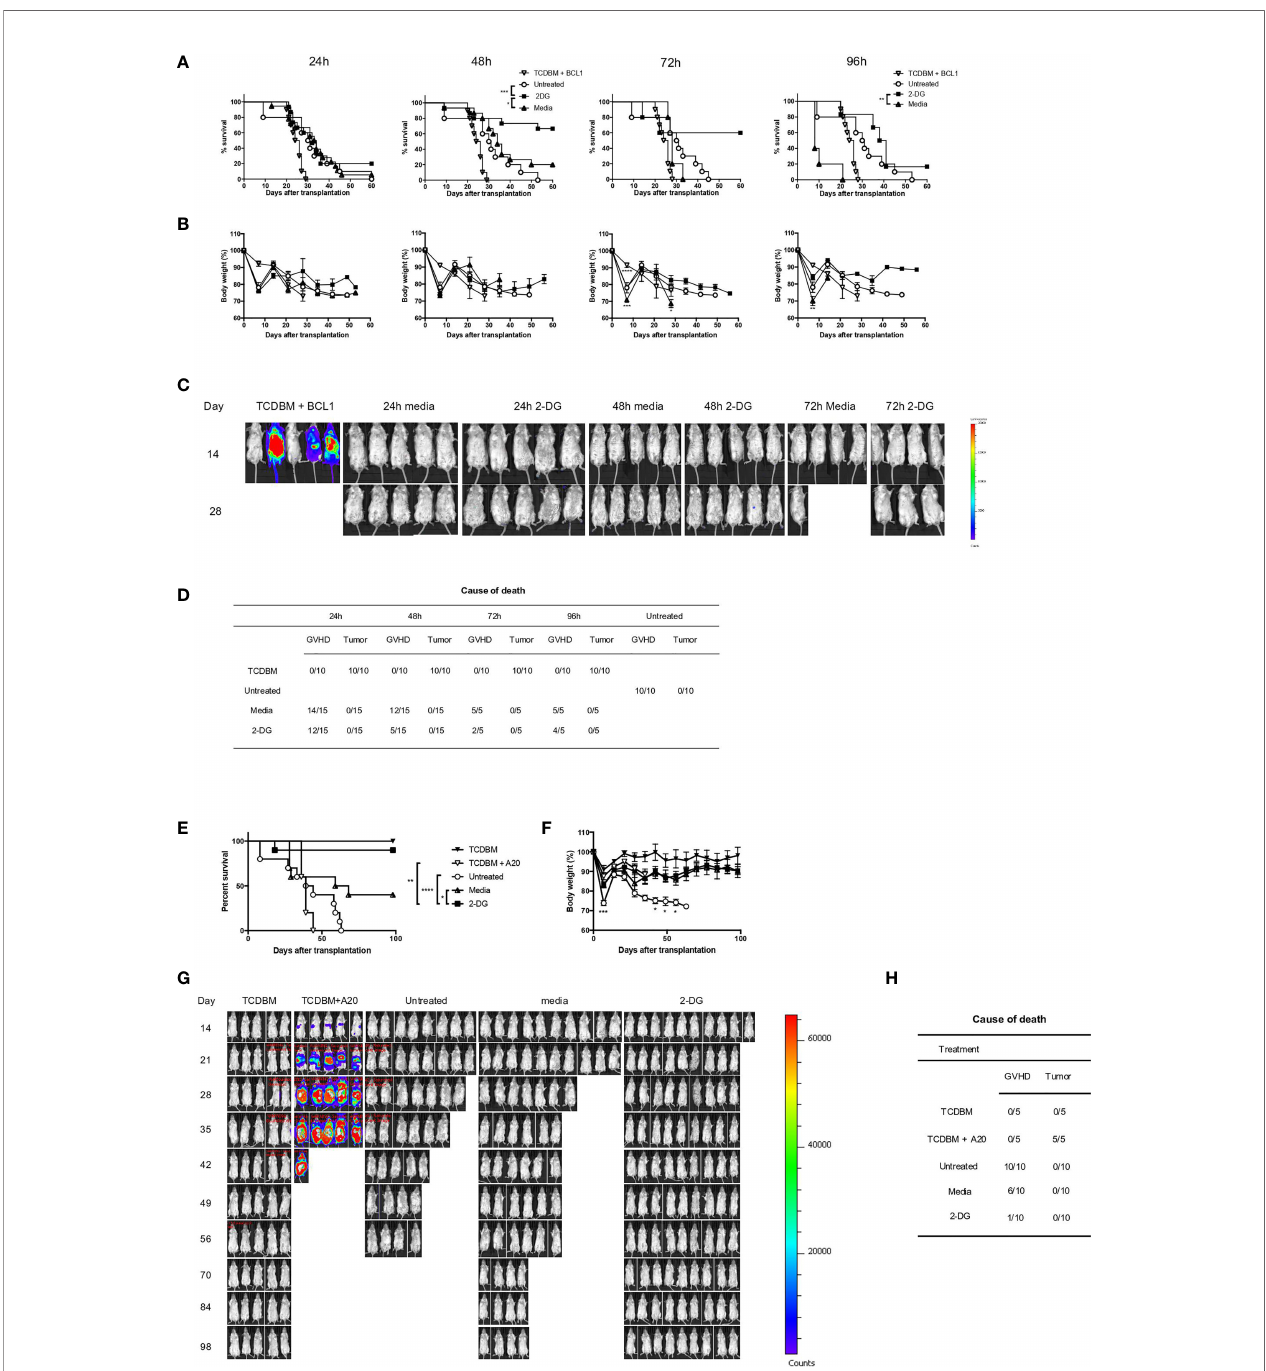
FIGURE 6 | 2-DG treatment ameliorates GVHD and preserves GVL effect. 1 x 10 6 T cells from C57BL/6 donor spleens were fi rst stimulated for 16 hours with irradiated BALB/c splenocytes, followed by addition of 8mM 2-DG or media control for indicated periods. T cells treated ex vivo or untreated control T cells at the same dose were transplanted into BALB/c recipients, along with 1 x 10 7 TCDBM from C57BL/6 donors and 5 x 10 5 BCL1 cells. Recipients were monitored for survival (A) , body weight (B) , and tumor growth in TCDBM and TCDBM + BCL1, 24-hour, 48-hour and 72-hour media control or 2-DG-treated groups. Tumor development was detected using BLI imaging on day 14 and day 28 following transplantation (C) . Cause of death due to GVHD or tumor development was summarized for different groups (D) . 1 x 10 6 T cells treated as shown in (A) for 48 hours or untreated control T cells at the same dose were transplanted into BALB/ c recipients, along with 1 x 10 7 TCDBM from C57BL/6 donors and 1 x 10 5 A20 cells. Recipients were monitored for survival (E) , body weight (F) , and tumor growth (G) . Cause of death was summarized for various groups (H) . *P < 0.05, **P < 0.01, ***P < 0.001, log-rank test; data are representative of two experiments (n = 15 per group, recipients for 24-hour and 48-hour ex vivo cultured T cells; n = 5, recipients for 72-hour and 96-hour ex vivo cultured T